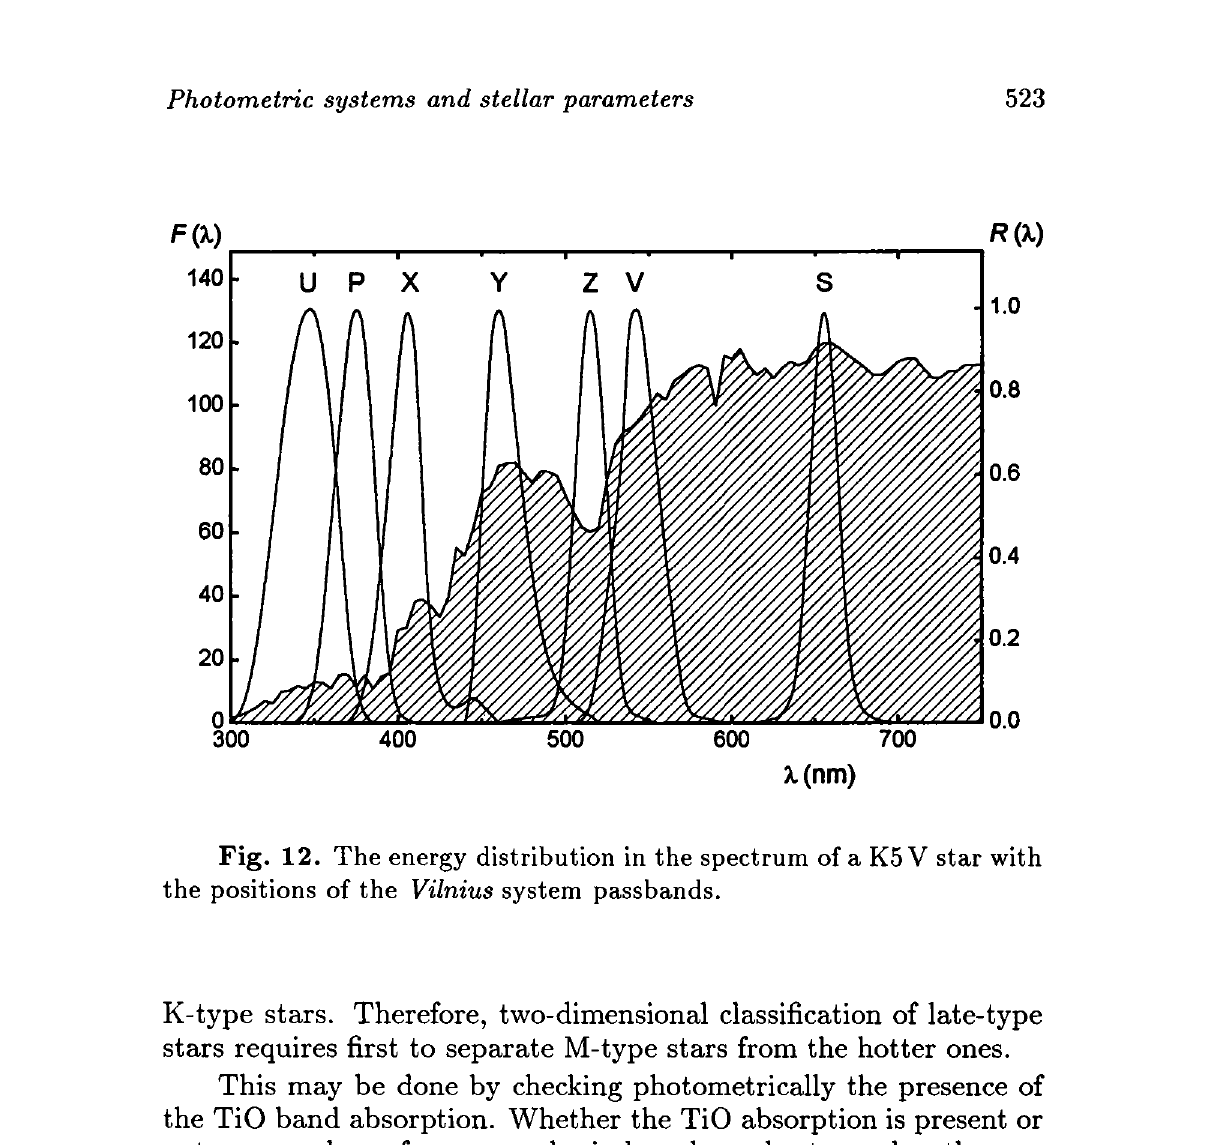
Fig. 12. The energy distribution in the spectrum of a K 5V star with the positions of the Vilnius system